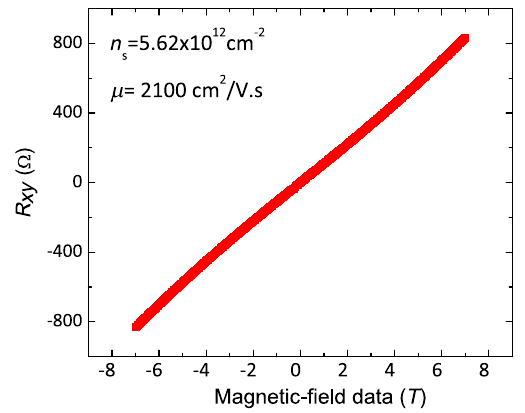
FIG. 4. R xy vs magnetic-field data (T) taken at 300 K. Typically, sample mobilities are in the range of 1400 – 2100cm 2 = Vs and carrier densities (holes) are in the range of 2 – 8 (cid:3) 10 12 cm 2 .